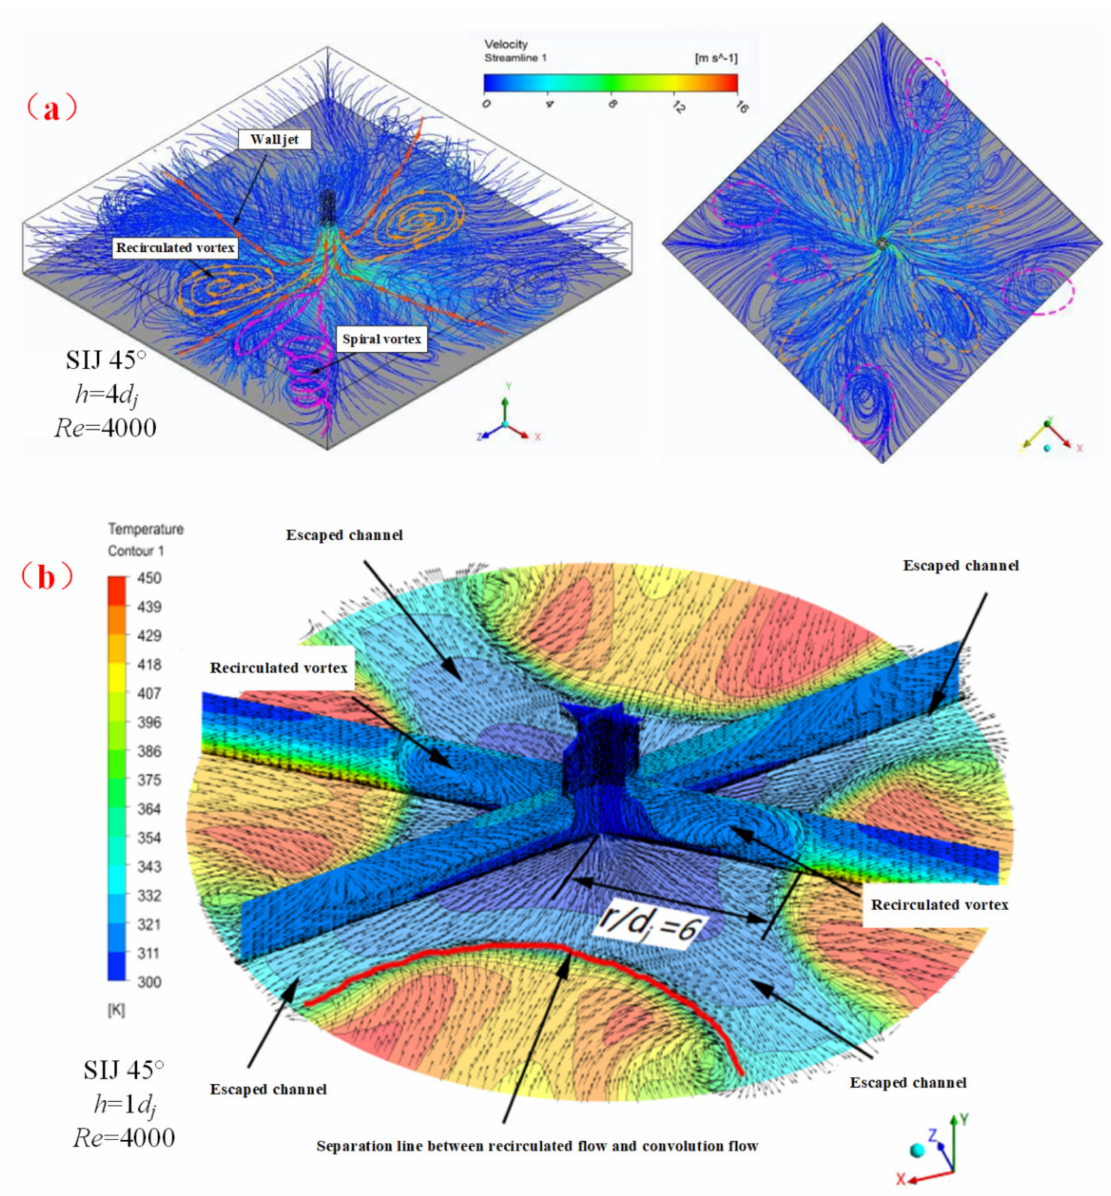
Figure 11. ( a ) Three-dimensional (3D) streamlines of jet space and ( b ) velocity field of jet